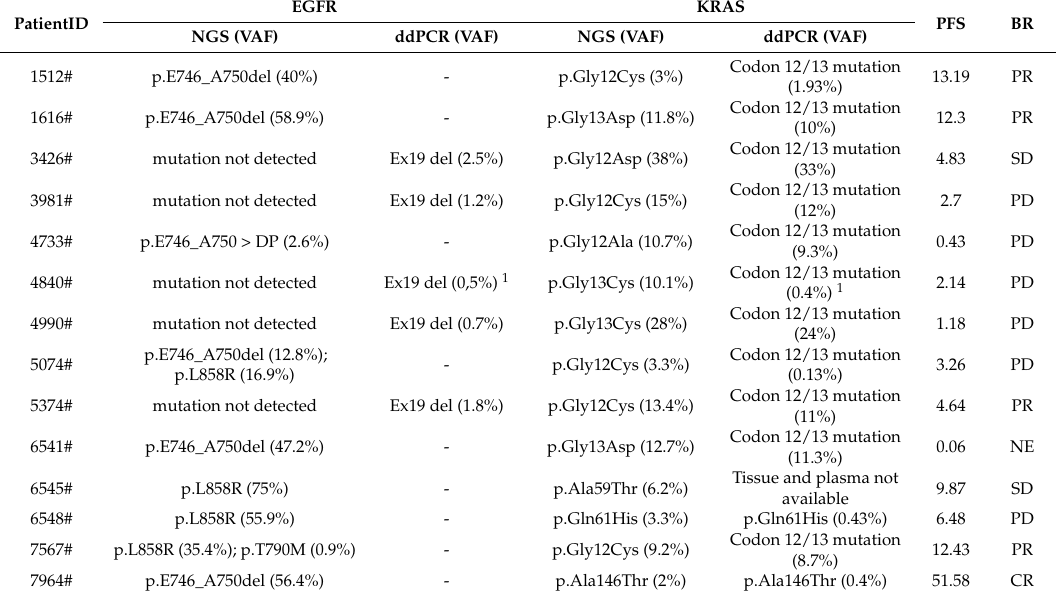
Table 2. KRAS-mutant cases.